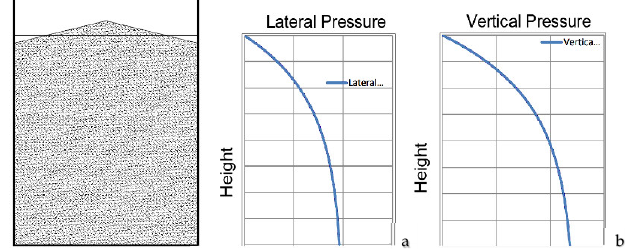
Figure 4. Silo and wall loads: ( a ) normal pressure; ( b ) vertical compression variation.